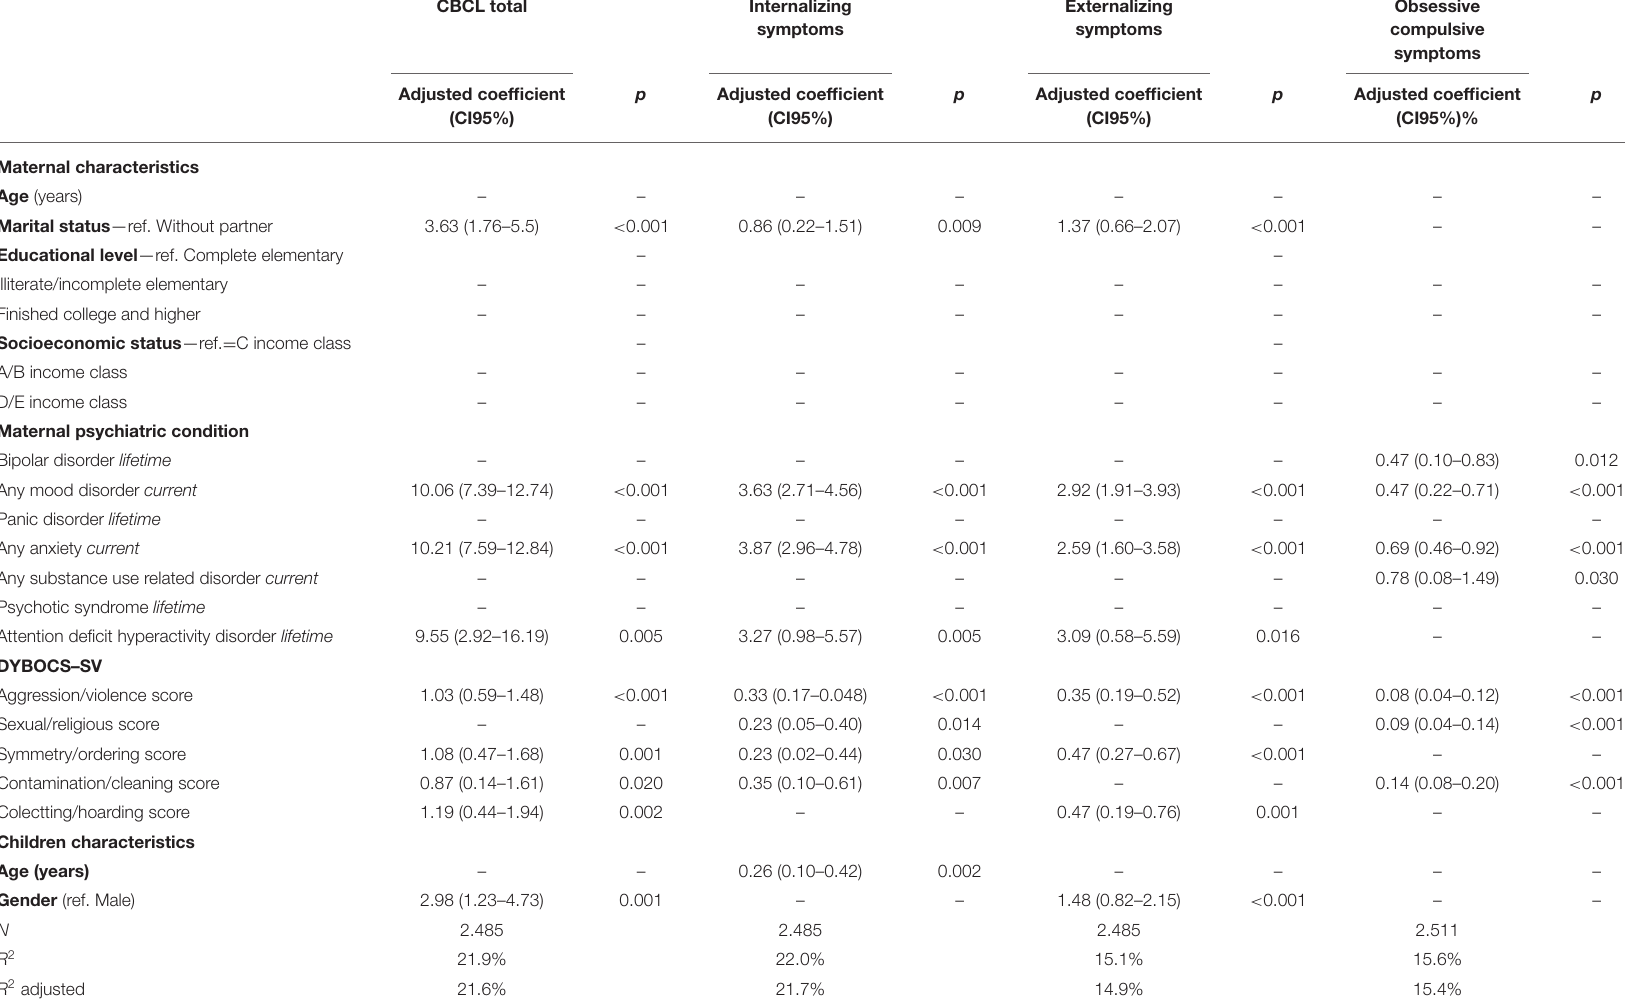
TABLE 3 | Multivariate linear regression analyzing CBCL internalizing, externalizing and OCS scores according to maternal and children’s characteristics. CBCL